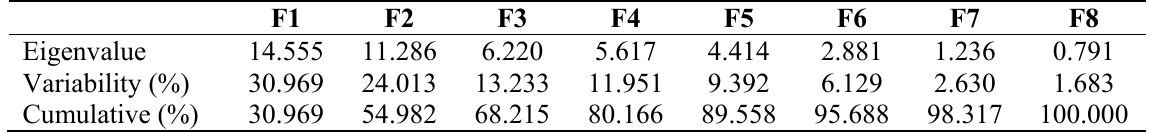
Legend: The table shows the contribution of each factor to the percentage of variability detected in the observations. The factors kept for further analysis are presented in